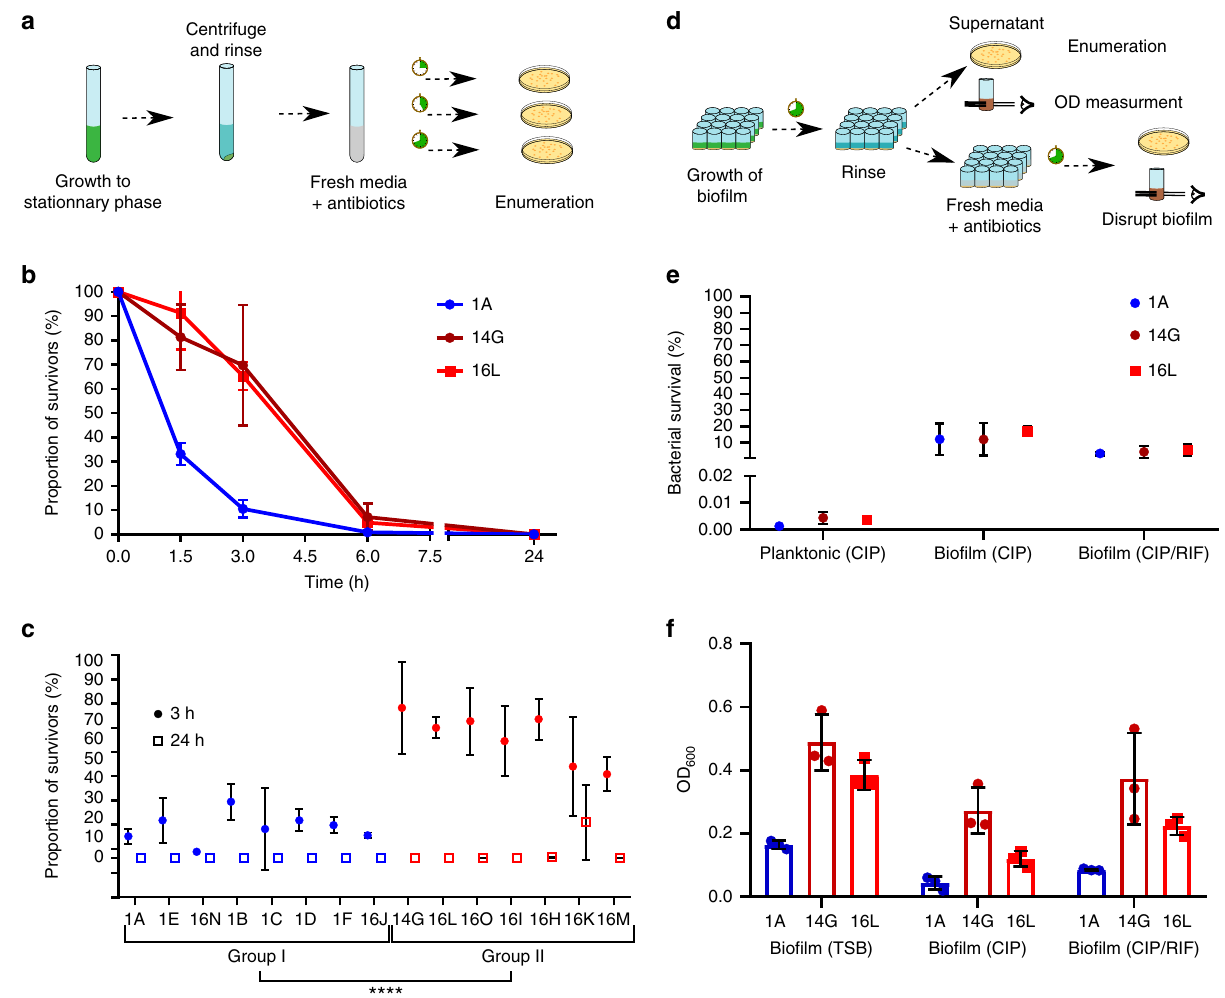
Fig. 6 Antibiotic clearance of planktonically growing and bio fi lm-embedded bacteria . a Illustration of the assay used to determine the proportional killing of a bacteria population by antibiotics. b , c Cipro fl oxacin killing of stationary growth phase bacteria. Bacteria were exposed to at least 40-fold MIC of cipro fl oxacin for b 1.5, 3, 6, and 24h and for c 3 and 24 h, respectively. The proportion of surviving bacteria relative to the inoculum was quanti fi ed by assessing the number of colony-forming units (CFUs) grown on agar plates. Curves and time points show averages of three replicates with standard deviation. Statistical signi fi cance of survival to 3 h antibiotic exposure between the two groups was determined by Welch's t test ( N = 46 t (30.86) = − 10.038, P = 3.069 × 10 − 11 ). A log scale representation is given in Supplementary Fig. 6a, b. d Illustration of the assay used to determine the antibiotic treatment ef fi ciency of bio fi lms. Bacterial killing within a bio fi lm was measured by enumerating CFUs, and disruption of the bio fi lm was quanti fi ed by optical density after treatment with antibiotics. e Antibiotic killing of bacteria embedded within a bio fi lm by cipro fl oxacin and a combination of cipro fl oxacin and rifampicin as compared with stationary phase grown bacteria (same data points as shown in b ). The proportion of surviving bacteria relative to the bacteria recovered from the pre-grown bio fi lm was quanti fi ed by assessing the number of CFUs grown on agar plates. Averages with standard deviation of three replicates are shown. A log scale representation is given in Supplementary Fig. 6c. f Quantitative in vitro bio fi lm assays of untreated, cipro fl oxacin, and a combination of cipro fl oxacin- and rifampicin-treated bio fi lm. Bio fi lms were quanti fi ed by OD 600 measurement. Averages with standard error of mean of three replicates are shown. Group I and group II isolates are indicated in blue and red, respectively. Dark red indicates the clinical isolate retrieved from the blood culture. **** P <